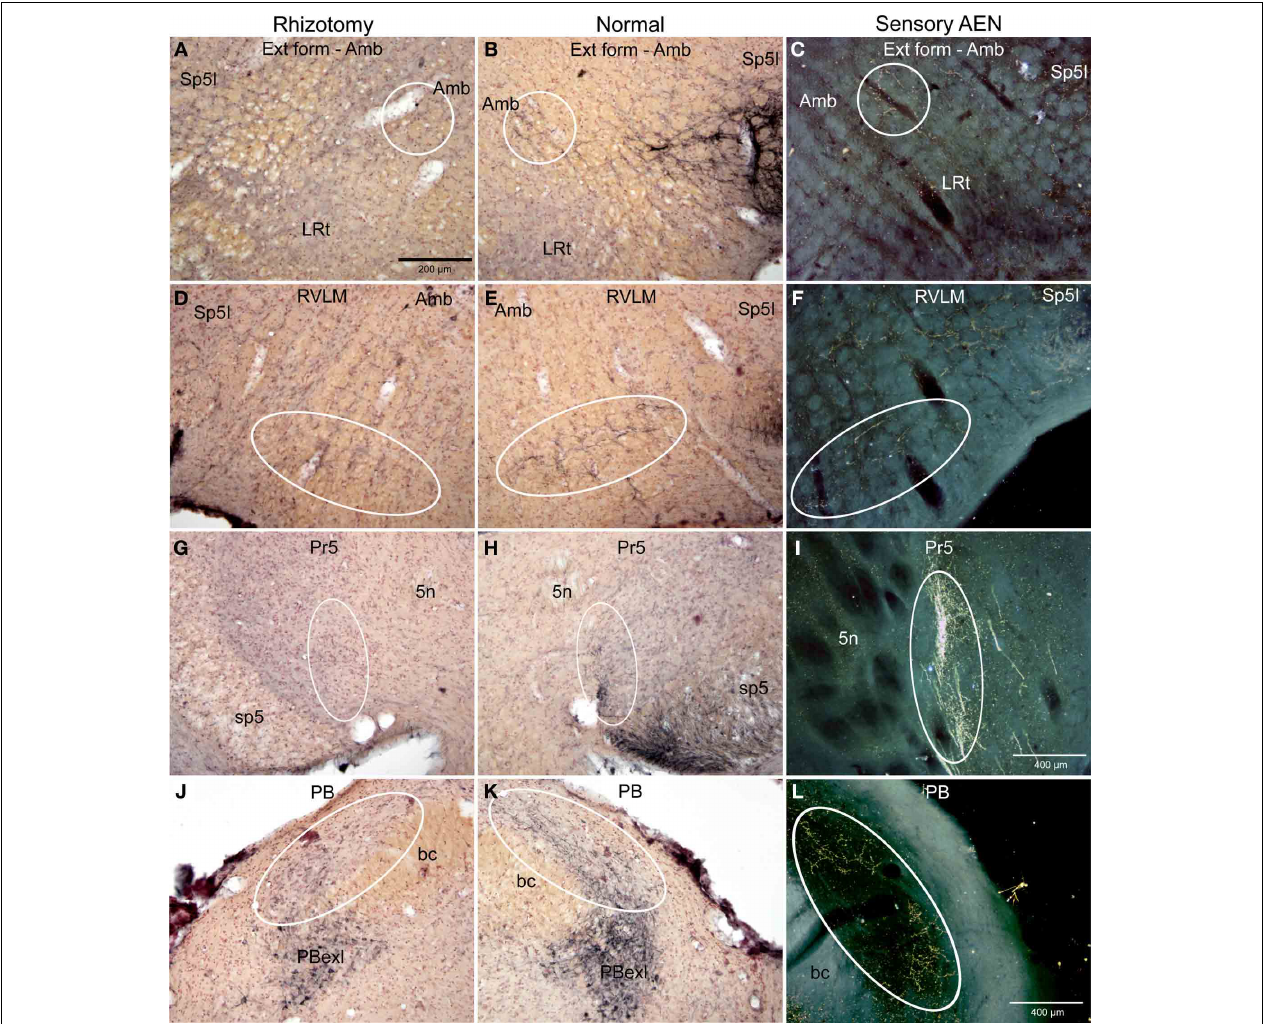
FIGURE 5 | Photomicrographs of sections illustrating loss of CGRP immunoreactivity in the lateral brainstem after unilateral trigeminal rhizotomy. Compare the distribution of CGRP fibers on the non-experimental side ( B , E , H ; Normal) to fibers of the anterior ethmoidal nerve, a branch of the trigeminal, labeled after transganglionic transport ( C , F , I ; Sensory AEN). Note the striking similarity of these two distributions. The CGRP-labeled fibers juxtaposed to nucleus ambiguus ( B , encircled; Amb) includes the external formation of Amb where preganglionic cardiac motor neurons are found. Moreover, CGRP-labeled fibers in the ventral RVLM ( E , encircled), where C1 adrenergic neurons are located, match the distribution of primary afferent